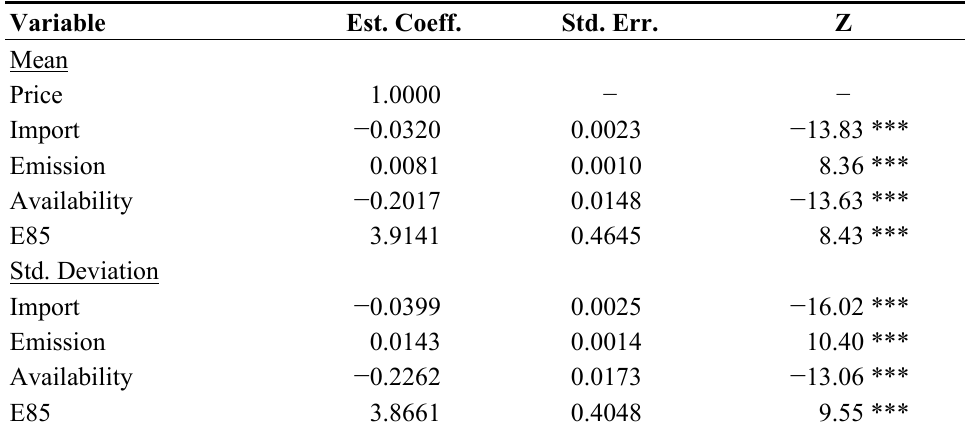
Table 2. Estimated mixed logit model a,b .